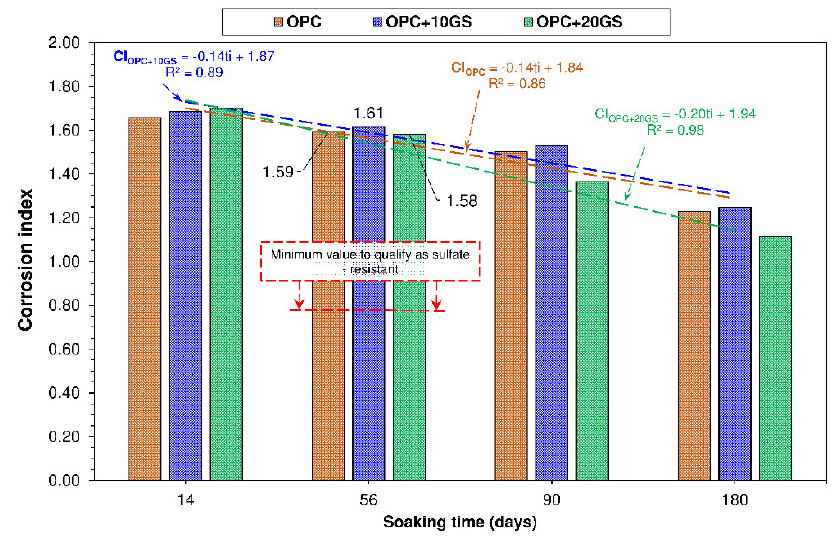
Figure 6. Corrosion index versus soaking time (t i ).